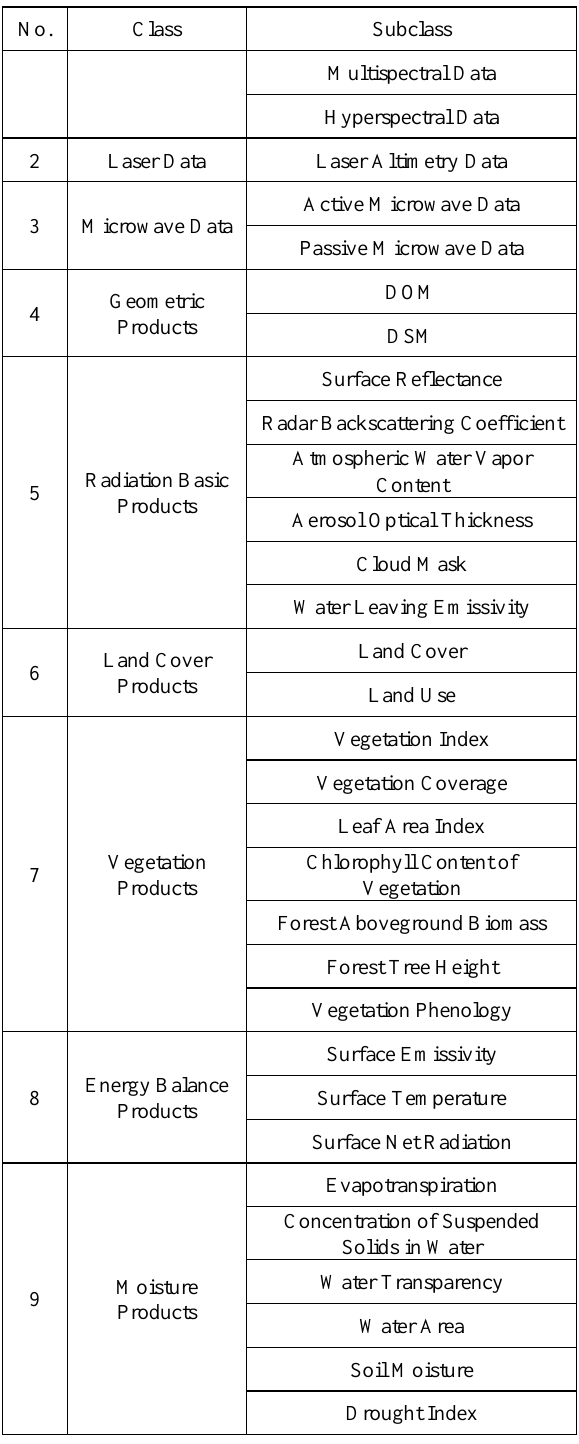
Table 1. List of natural resources satellite remote sensing data and common